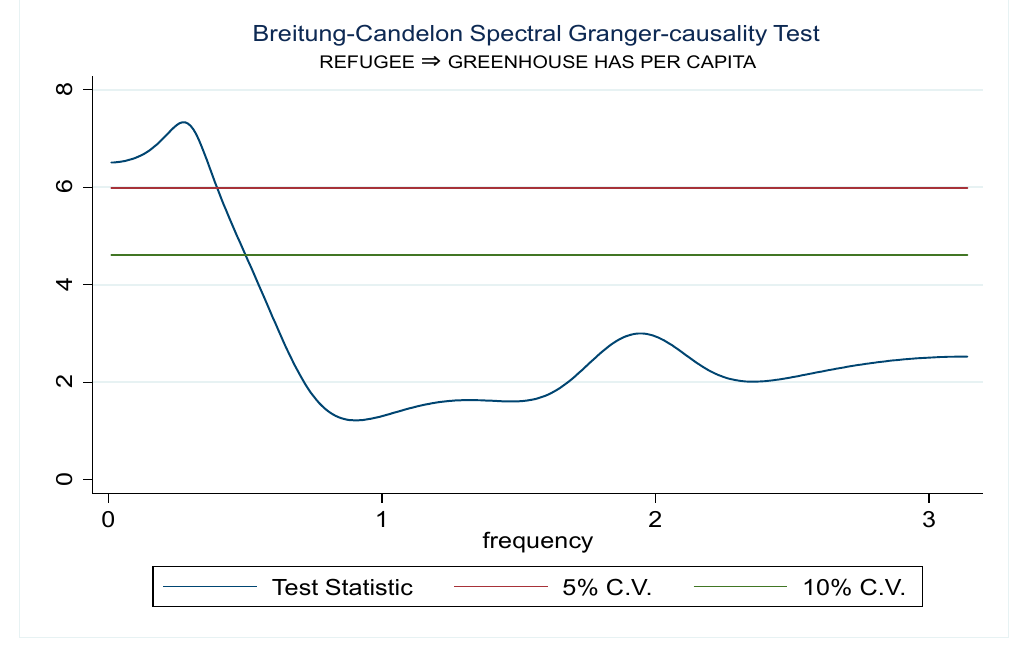
Figure 3. Evidence of causality from refugee to GHG per capita emissions in Sweden.